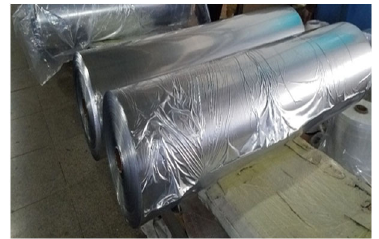
Figure 5. Sticking of the film sleeve.